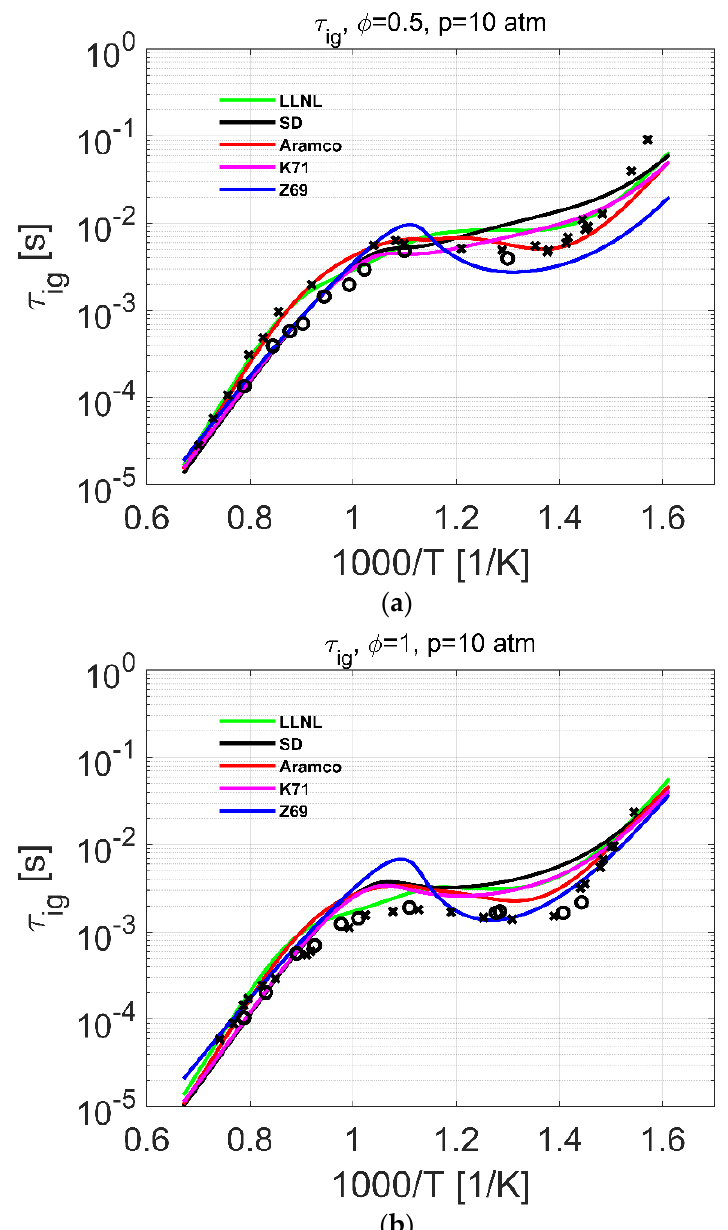
Figure 6. Ignition delay time for DME-air mixtures at 10 atm and ϕ = 0.5 in ( a ) and ϕ = 1.0 in ( b ). Legend: experimental data for τ ig from ( ) Jiang et al. [15] and (×) Burke et al. [17]. Mechanism predictions from Z69 in blue, LLNL in green [28], Aramco in red [17], K71 in magenta [32] and San Diego in black [30].